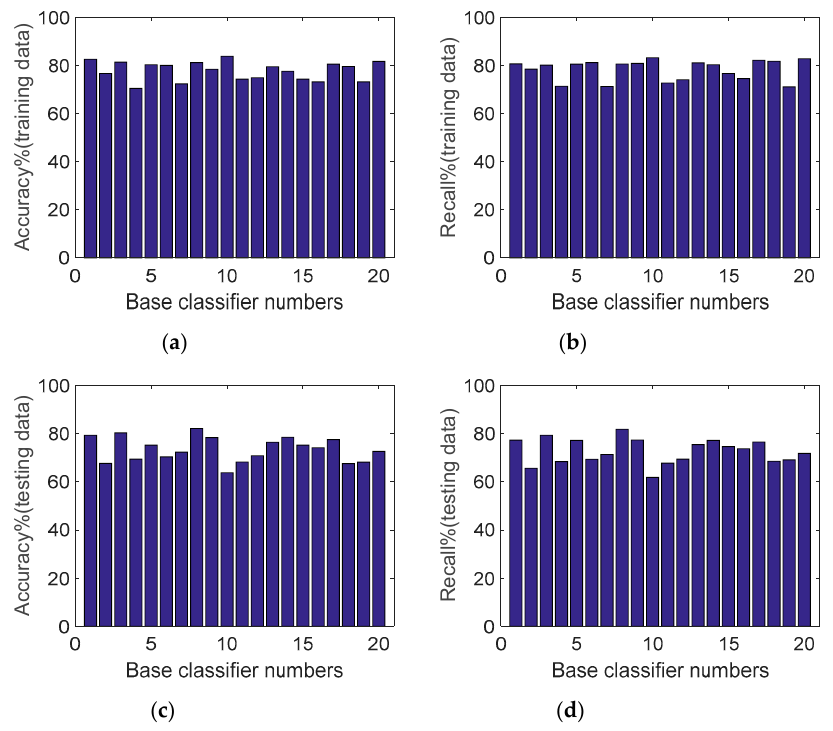
Figure 12. The accuracy and recall for each base classifier: ( a ) the accuracy of each base classifier in training data, ( b ) the recall of each base classifier in training data, ( c ) the accuracy of each base classifier in testing data, and ( d ) the recall of each base classifier in testing data.